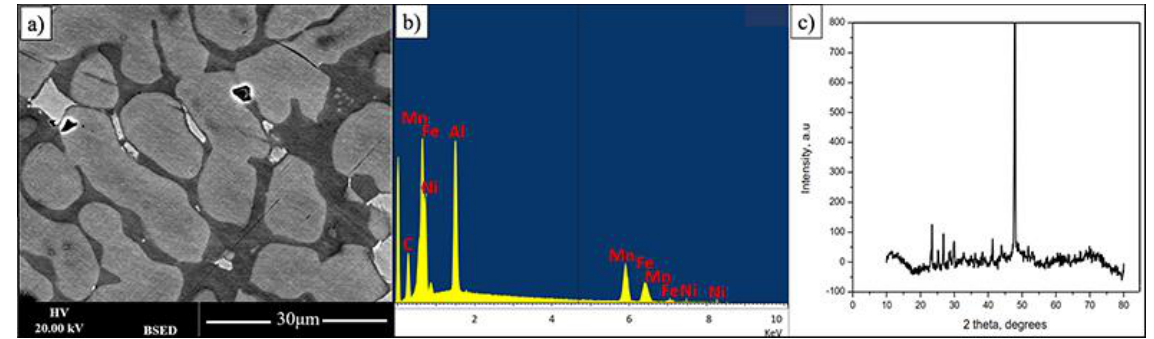
Figure 1. ( a , b ) BSE image and its EDX spectrum displaying three phases of FeMnNiAlC 10 bulk alloy processed by arc melting, ( c ) is the alloy XRD pattern.